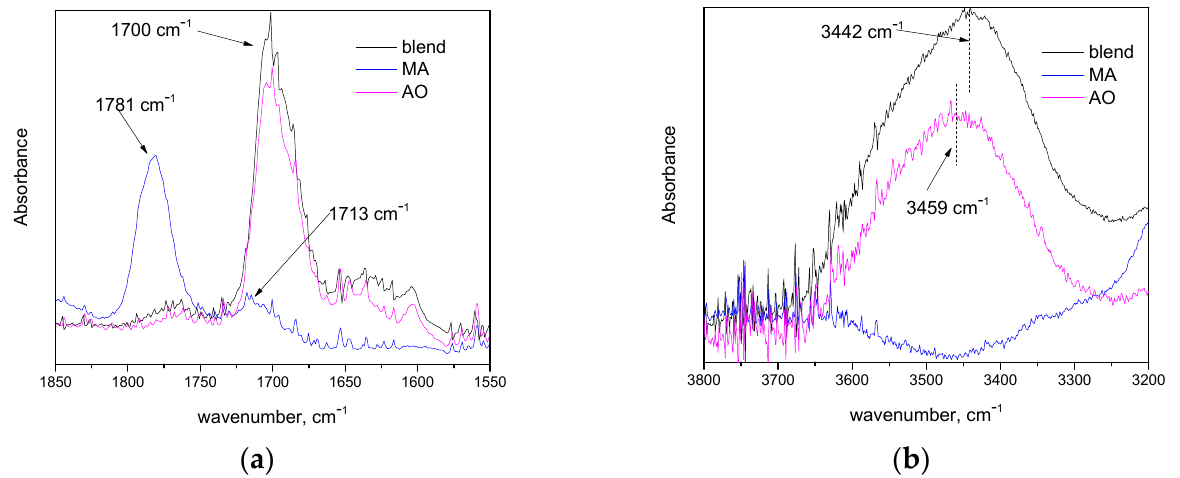
Figure 3. FTIR spectra of masterbatches that contain the compatibilizer (MA), the antioxidant (AO) and their blend ( a ) in the region 1550–1850 cm − 1 and ( b ) in the region 3200–3800 cm − 1 . In Figure 3a, the FTIR spectra, in the region 1550–1850 cm − 1 , of the compatibilizer masterbatch and the blend are presented. In this region, various >C=O vibrations occur. The absorptions at 1780 and 1713 cm − 1 in the spectrum of compatibilizer are attributed to the symmetric >C=O stretching in anhydride groups and carboxylic acids, respectively [33,34]. Similar absorptions for PP-g-MA have been reported in literature, while the acid-related >C=O vibration was attributed to acid formation due to the anhydride hydrolysis, during the high-temperature mixing, which was catalyzed by glass fibers [34]. In the antioxidant masterbatch, the absorption of the >C=O group appears at 1700 cm − 1 , which is charac- teristic of conjugated carbonyl groups. In the spectrum of the blend, no contribution of the peak at 1780 cm − 1 of PPg-MA can be detected. These observations suggest that in the blend, the absorption band of the carbonyl groups of MA has shifted (due to physical molecular interactions). In Figure 3b, the FTIR spectra in the region 3200–3800 cm − 1 are presented. In this region, phenolic compounds exhibit absorption due to –OH groups [35].